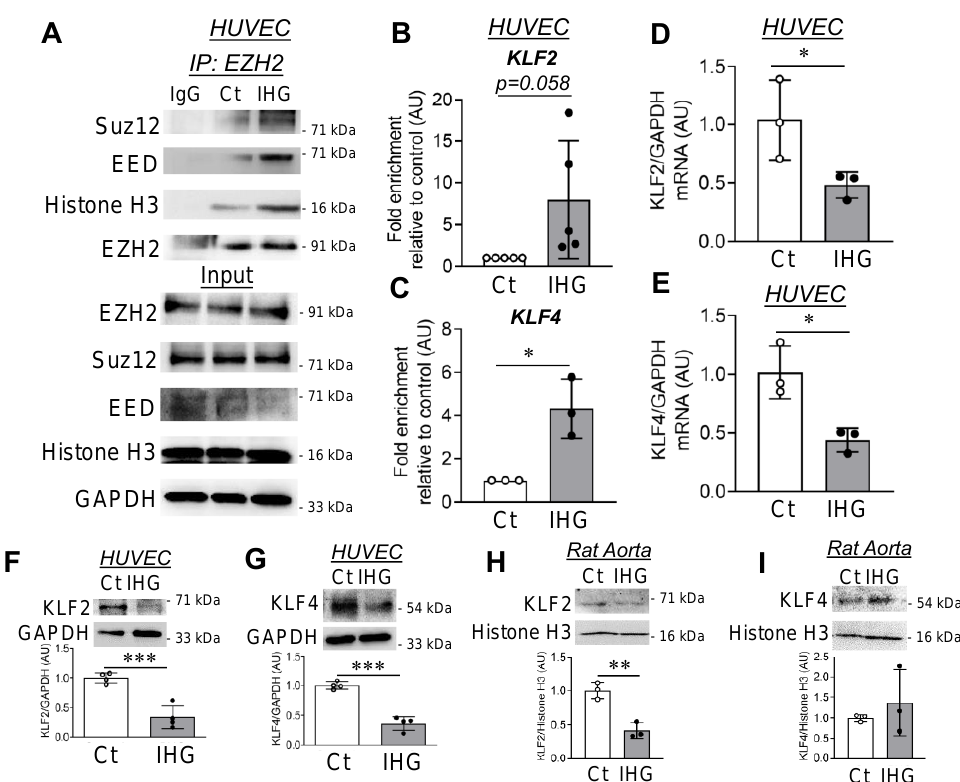
Figure 3. Intermittent hyperglycemia causes EZH2 coupling with PRC2 proteins, leading to H3K27 trimethylation at promoter regions of the KLF2 and KLF4 genes. ( A ) Co-immunoprecipitation with EZH2 antibody, followed by immunoblotting for Suz12, EED, and histone H3 in both immuno-precipitated and total cell lysate (input) sample ( n = 3). ( B , C ) ChIP assay using H3K27me3 antibody, followed by qPCR using primers specific to amplify promoter regions of KLF2 gene (( B ), n = 5) and KLF4 gene (( C ), n = 3) in HUVEC cells treated with intermittent high glucose. ( D , E ) Transcriptomic quantitation of KLF2 (( D ), n = 3) and KLF4 (( E ), n = 3) in HUVEC challenged with intermittent high glucose. ( F , G ) Immunoblotting and quantitation for KLF2 (( F ), n = 4) and KLF4 (( G ), n = 4) in intermittent high glucose-challenged HUVEC. ( H , I ). Tissue lysates of intermittent high glucose-treated rat aortic rings were immunoblotted for KLF2 (( H ), n = 3) and KLF4 (( I ), n = 3). Control treatment condition (cells constantly exposed to normal glucose (5.5 mM)) represented as “Ct” in the figure. All analyzed data were normalized to the control treatment condition. Values represent the mean ± SD. * p < 0.05, ** p < 0.01, and *** p < 0.001 by unpaired t test.